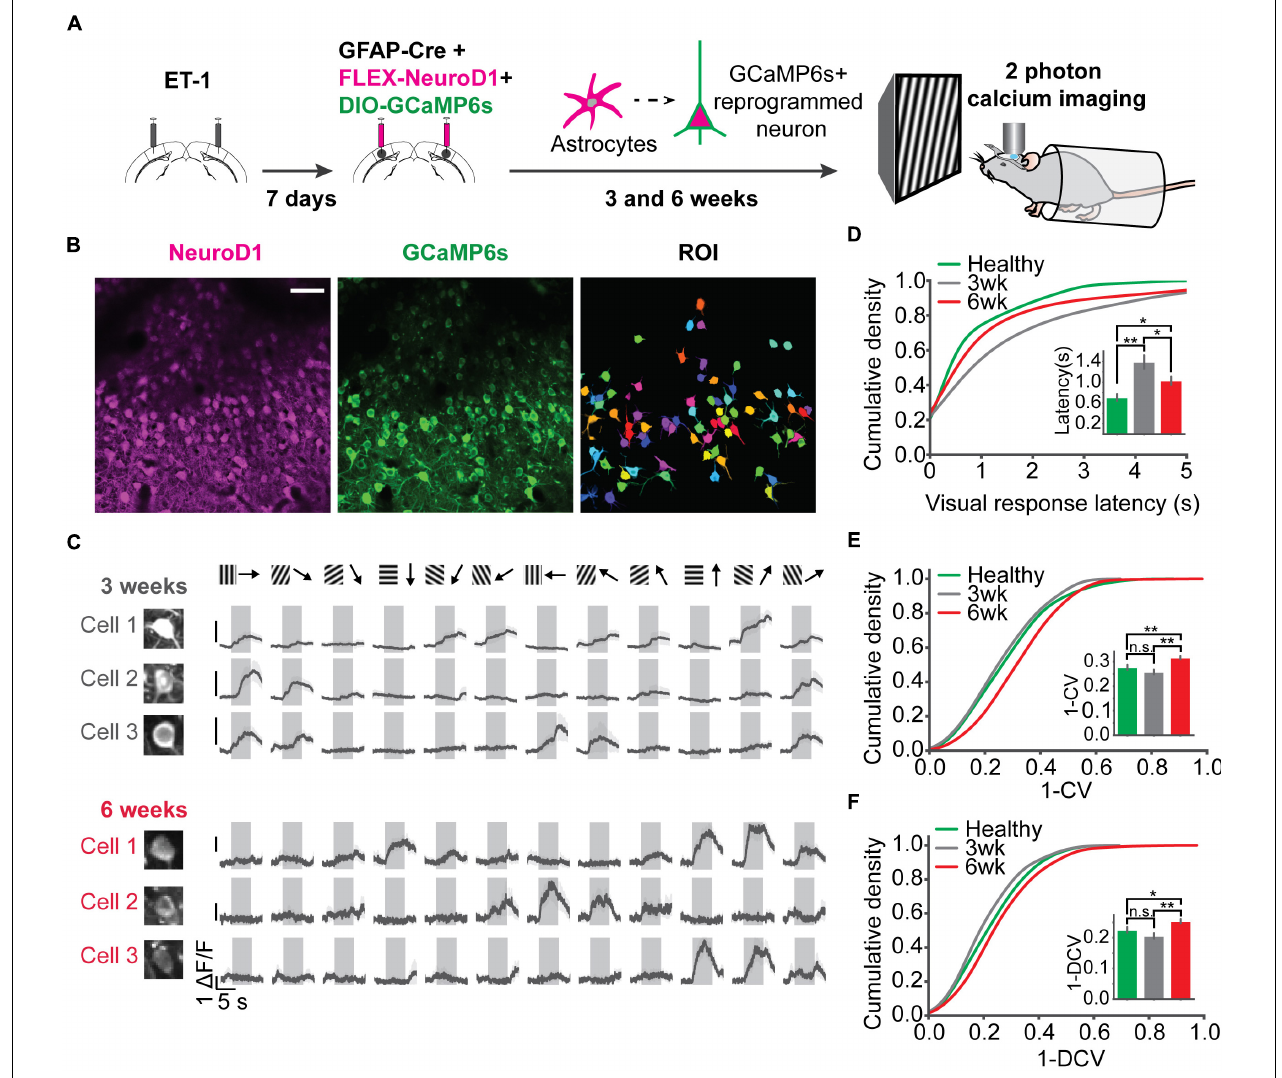
FIGURE 7 | Two-photon calcium imaging reveals response latency decrease and direction selectivity improvement of the reprogrammed neurons over time. (A) Injection scheme for two-photon calcium imaging. ET-1 was first injected to induce a focal stroke. 7 days after ET-1 injection, AAV-GFAP::Cre, AAV-FLEX-NeuroD1-mCherry, and AAV-FLEX-GCaMP6s were injected in the same sites. Reprogrammed cell activities in awake mice were imaged by a two-photon microscope at 3 and 6 weeks after viral injection (at the age of 3-3.5 months old). For the healthy control, AAV-syn-jGCaMP7s was injected into mouse V1, and cell activities were imaged at 3-4 weeks post-injection (at the age of 2.5 months old). (B) NeuroD1 and GCaMP6s signals were well overlapped. Well isolated ROIs were chosen for further analysis. Scale bar represents 50 µ m. (C) Trial-averaged traces of representative cells showed selective responses to 12 directions. Shaded areas represent visual stimulation. (D) The cumulative density of visually evoked response latencies of cells at 3 and 6 weeks after viral injection, compared with cells in healthy control mice. Quantification of latencies shown in the inset. N 3 week = 187 ROIs from 3 mice, N 3 week = 181 ROIs from 5 mice, N 6 week = 375 ROIs from 5 mice. 3 week vs. 6 week: p = 0.023; 3 week vs. Healthy: p = 0.001; 6 week vs. Healthy: p = 0.045, One-way ANOVA followed by Tukey post hoc tests. (E) Cumulative density curves of 1-CV of the reprogrammed cells at 3 and 6 weeks after viral injection. Quantification of 1-CV shown in the inset. 3 week vs. 6 week: p = 0.001; 3 week vs. Healthy: p = 0.392; 6 week vs. Healthy: p = 0.005, One-way ANOVA followed by Tukey post hoc tests. (F) Same as (E) but for 1-DCV. Quantification of 1-DCV shown in the inset. 3 vs. 6 week: p = 0.001; 3 week vs. Healthy: p = 0.341; 6 week vs. Healthy: p = 0.036, One-way ANOVA followed